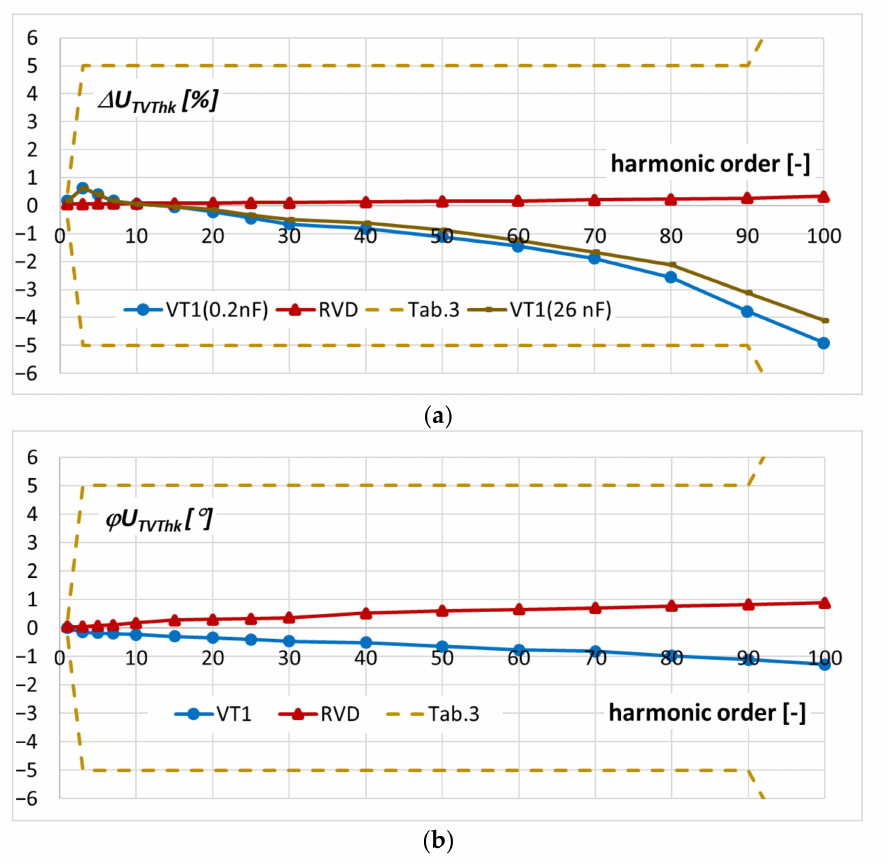
√ 3) kV and the wideband reference voltage divider: